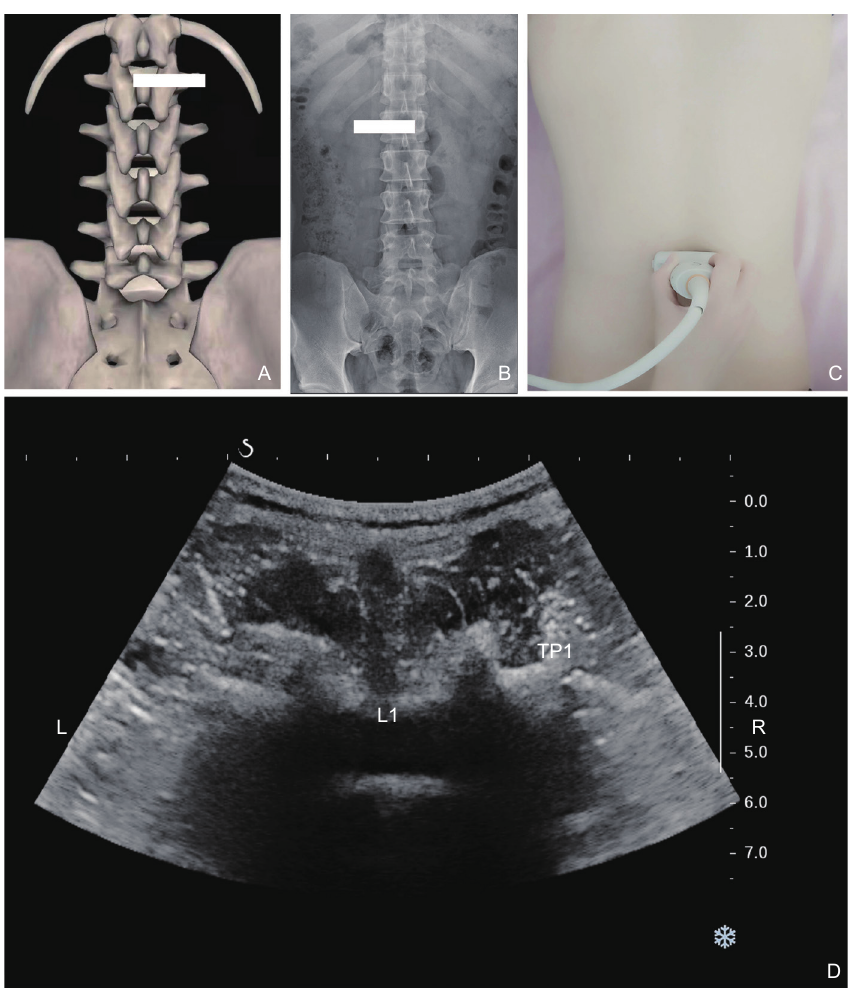
Figure 4 Transverse section of L1. (A) The white line indicates the position of the probe on the reconstructed CT image, (B) The white line indicates the position of the probe on the X-ray image. (C) The position of the probe on human skin. (D) Transverse ultrasound image of the L1 vertebra. Notice no connection of the rib and the vertebra. L1, the first lumbar vertebra; TP1, the transverse process of L1.